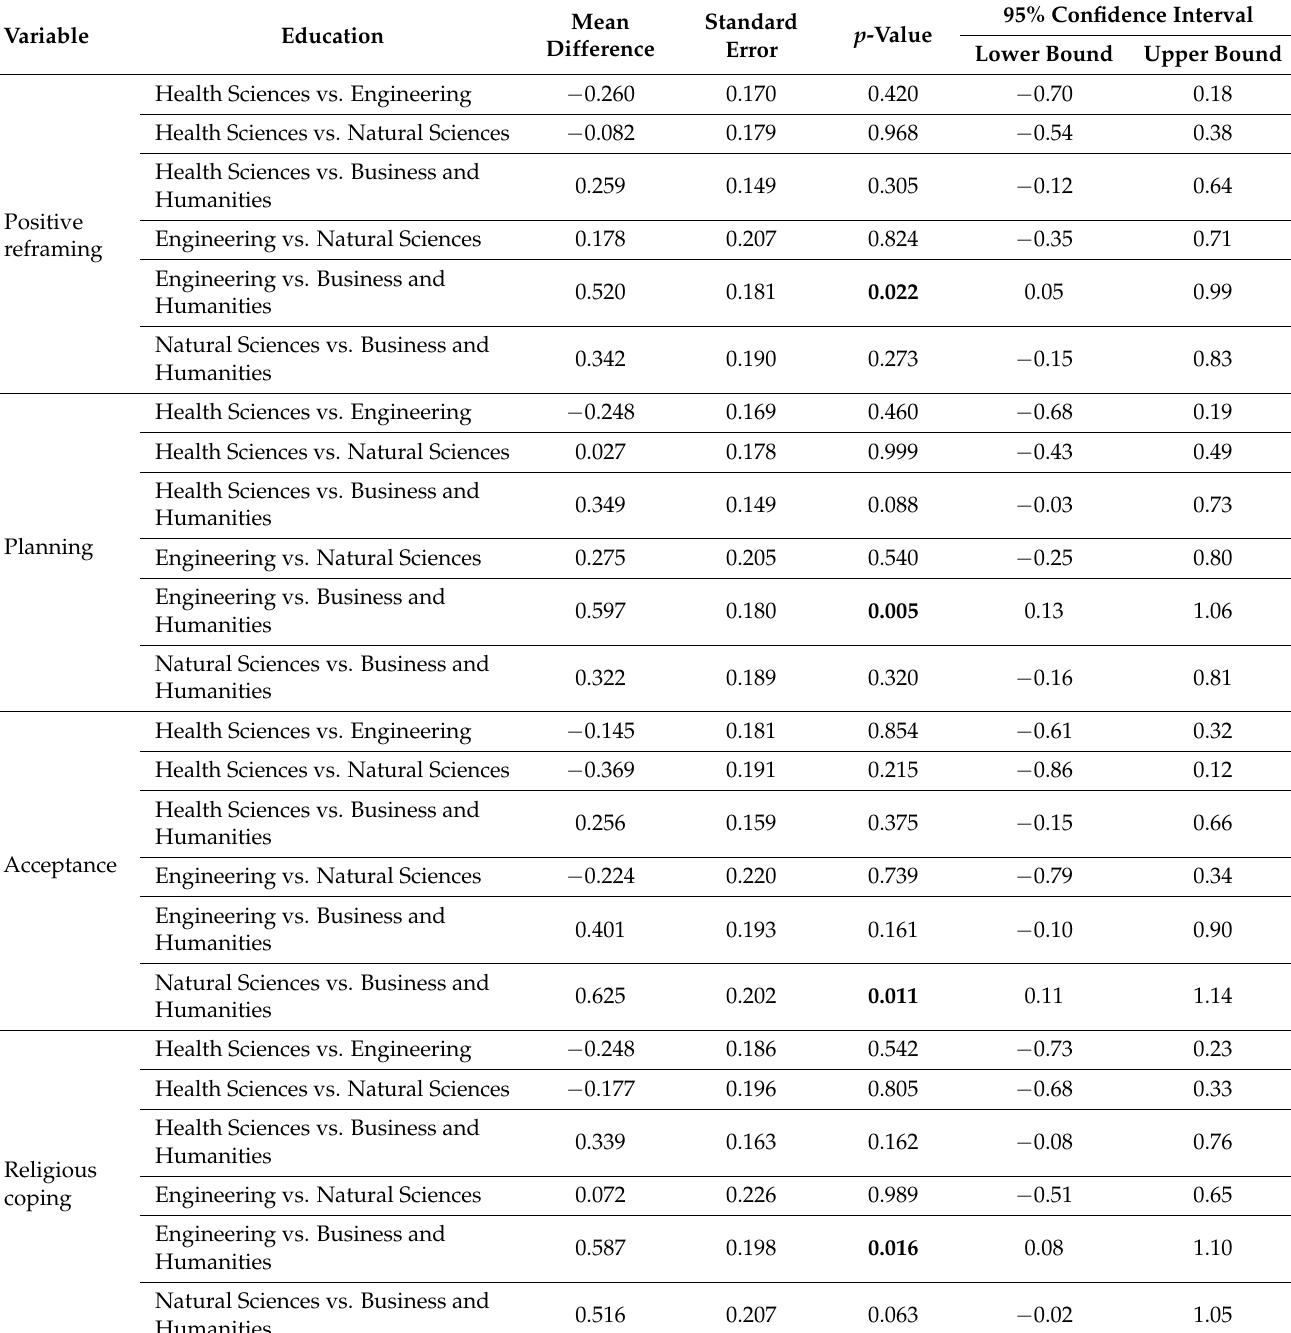
Table 3. Multiple comparisons of the coping strategies according to the Discipline of